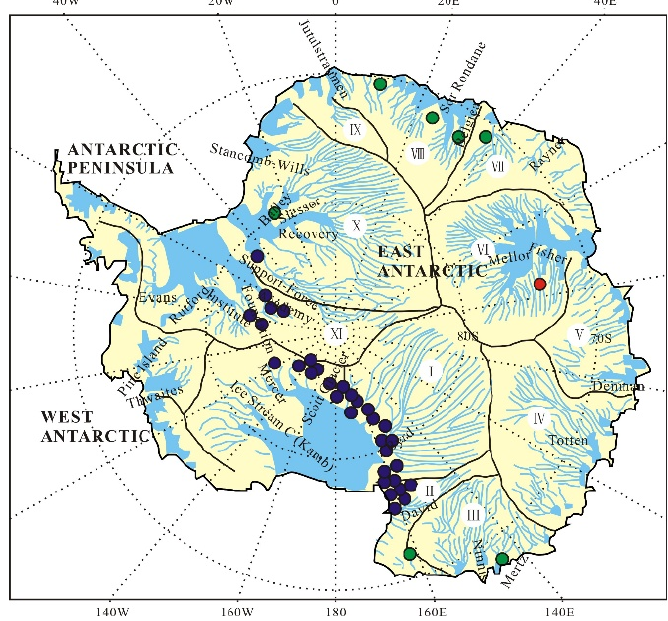
Figure 1. Map of meteorite concentration sites in Antarctica (based on the literature [14]). The red dots, blue dots, and green dots represent the meteorite enrichment areas found by China, the United States, and Japan and other countries, respectively.